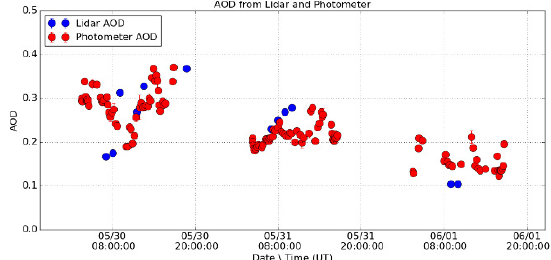
Figure 1 AOD from lidar and sun photometer during the campaign The PBL height from lidar varied between 600m to about 2000m. A second layer is also visible in all days. The ECMWF prognosis is completely missing the PBL height during the night (depicted as very close to zero-red in Figure 2) while during the day is between the values of the first layer detected in the lidar data and PBL height (Figure 2). The forecast dust model (DREAM,